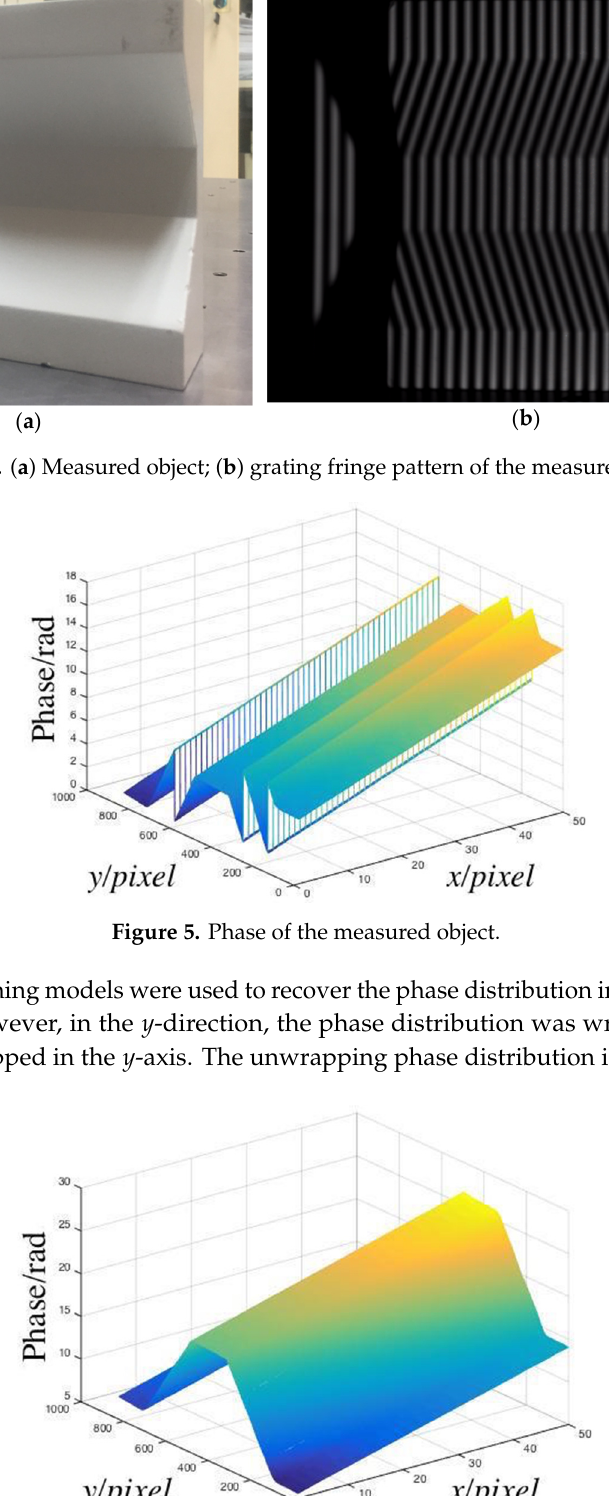
Figure 6. Unwrapped phase of the measured object.